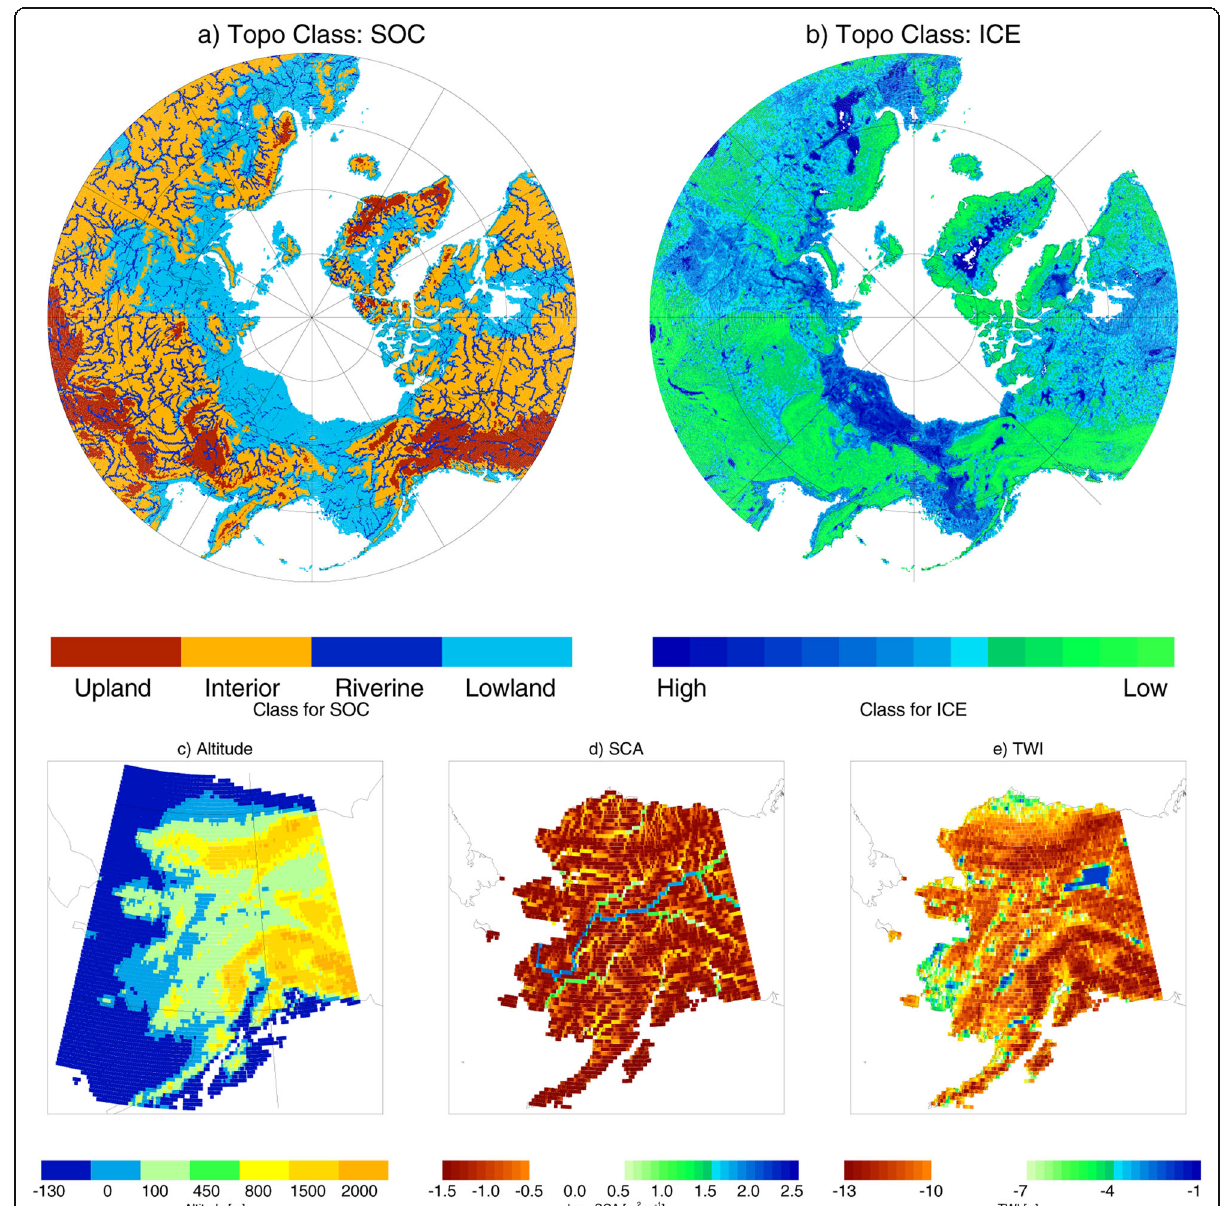
Fig. 3 Maps of topography classes and topographic-hydrological variables. Circum-Arctic distributions of topography classes used for a SOC and b ICE. Maps for the Alaskan area of c altitudes, d specific catchment area (SCA), and e topographic wetness index (TWI) calculated from a digital elevation model ETOPO1 and by the Terrain Analysis Using Digital Elevation Models (TauDEM) software developed by David Tarboton, Utah State University. Details of classification criteria are described in